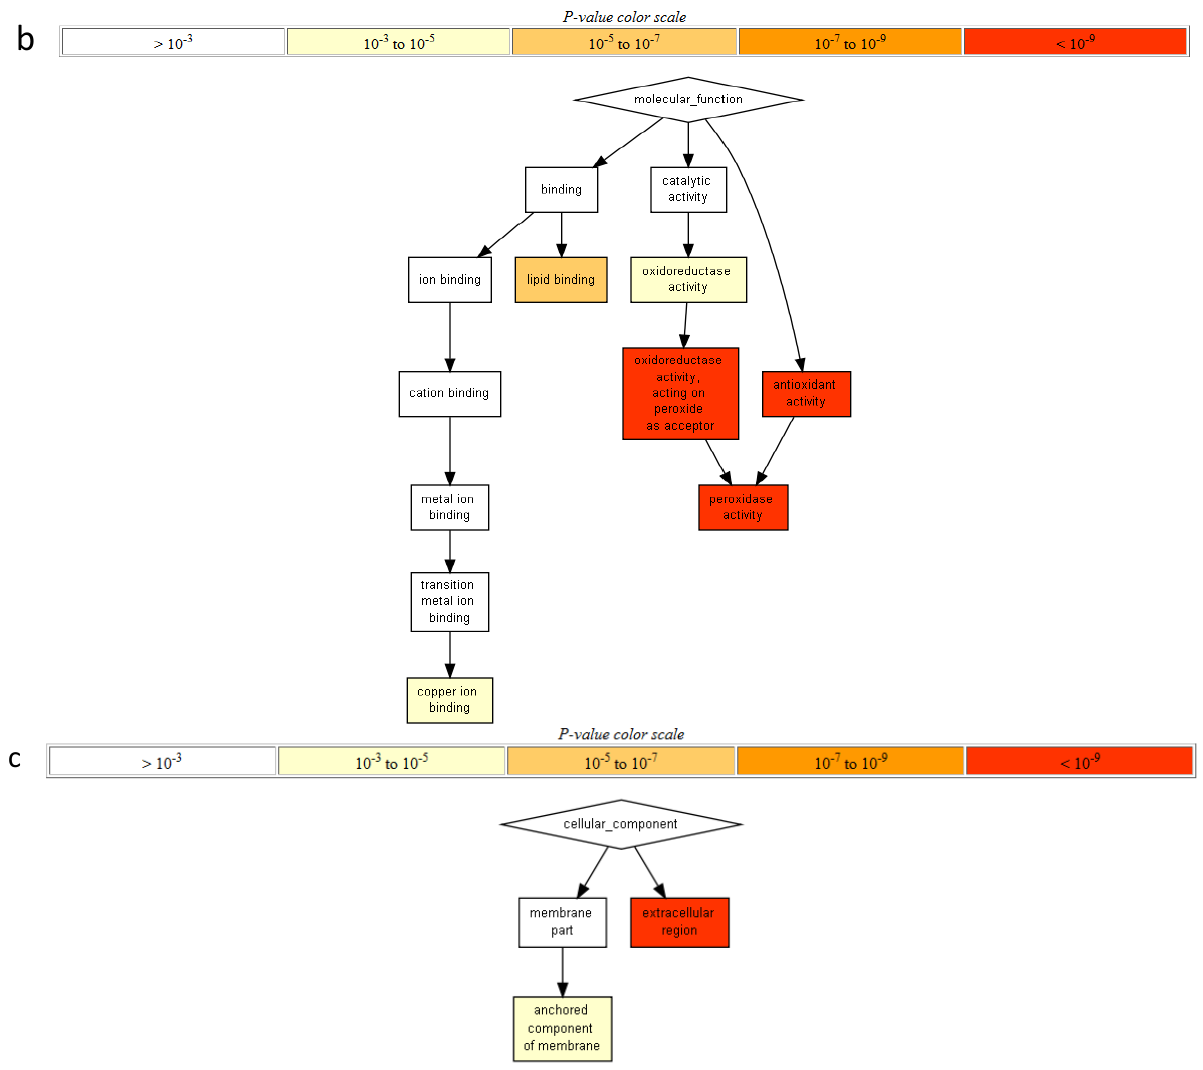
Figure 2. Gene Ontology (GO) term enrichment based on GO terms for total up-regulated genes by AgNP and Ag + stresses. GO term enrichment results for ( a ) Biological processes; ( b ) Molecular function; and ( c ) Cellular components were presented. All colored boxes are enriched with q -value (FDR) less than 0.05 ( q < 0.05) and the density of color shows the degree of enrichment, i.e. , red ( p -value < 10 −9 ), dark orange ( p -value 10 −7 to 10 −9 ), orange ( p -value 10 −5 to 10 −7 ), yellow ( p -value 10 −3 to 10 −5 ) and white ( p -value > 10 −3